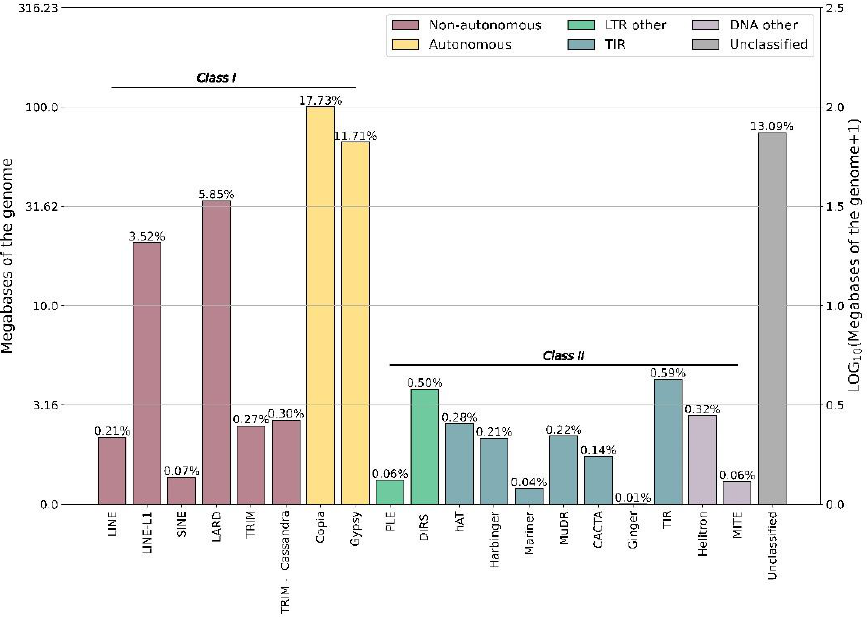
Figure 2. Repetitive elements (RE) identified in the Turnera subulata genome. Percentages represent the percent of each kind of RE. The graph is scaled to the log 10 (Megabases + 1) and shows the extent of the genome occupied by each element type.